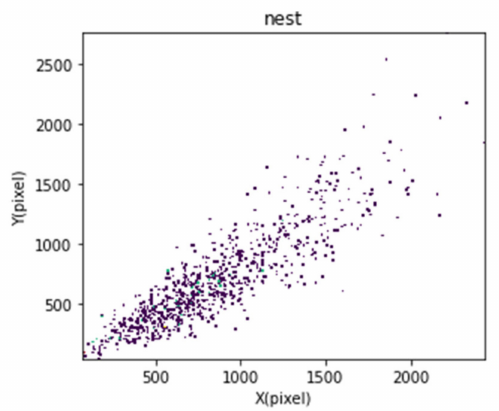
Figure 4. Annotation boxes clustering analysis. Please note that the abscissa X represents the width and the ordinate Y represents the